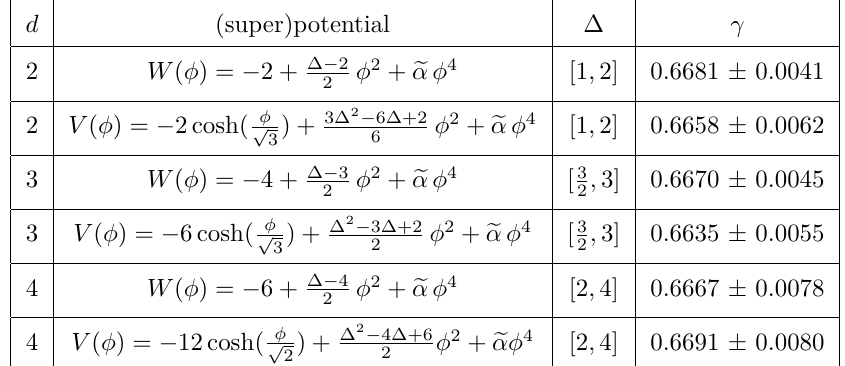
Table 1 . Means and standard deviations of critical exponents averaged over conformal weights